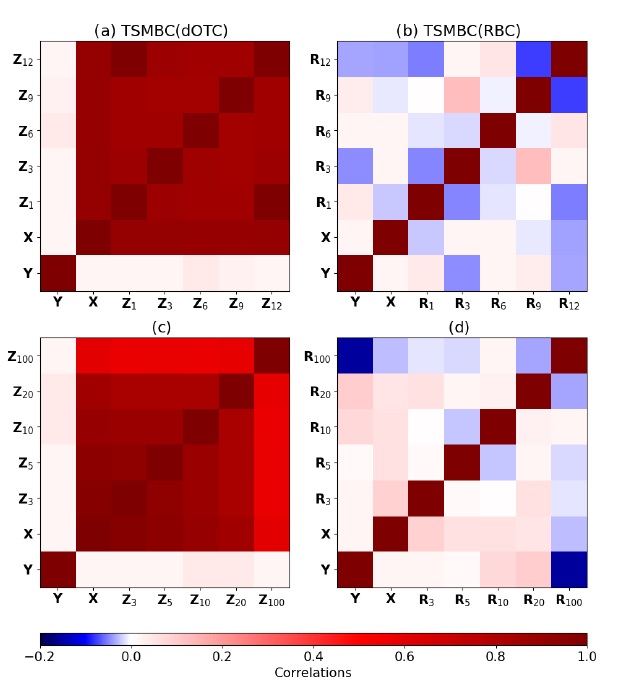
Figure 3. The first row (a, b) of matrices shows the correlations be- tween corrections of the VAR with different choices of starting row for the reconstruction step. The second row (c, d) shows the cor- relations between corrections of the VAR with different choice of lag. The starting row for the reconstruction step is the middle value between 0 and lag of corrections. Panels (a, c) show the correction with the method TSMBC with the underlying method dOTC, and (b, d) also show TSMBC, but with the underlying method